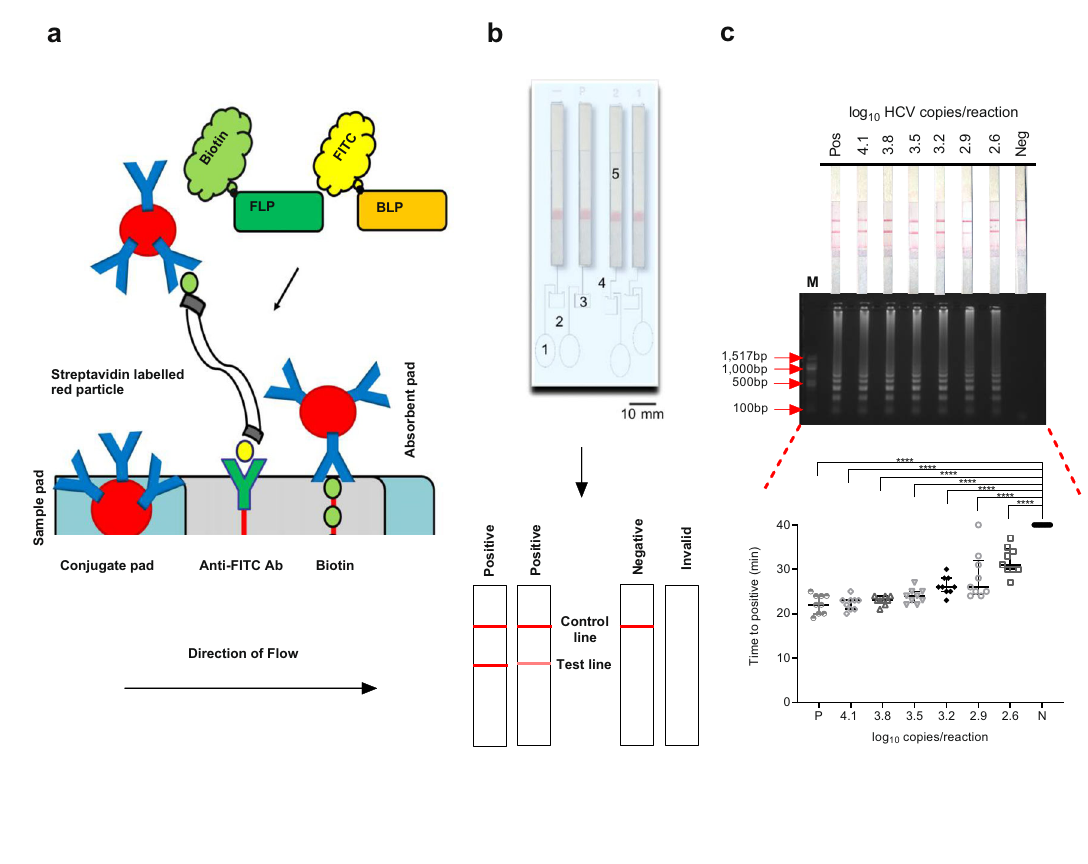
Fig. 3 Lateral fl ow detection of HCV LAMP assay. a The mechanism of the lateral fl ow strip 15 . Two primers, FLP and BLP, are pre-labelled with Biotin and FITC, respectively. The amplicon resulting from the LAMP reaction, contains both labelled primers as double-stranded DNA represented schematically by two gray lines. It is added onto the sample pad and moves towards the conjugate via capillary action. The streptavidin-labelled red particles bind with the Biotin (from the FLP primer) on the amplicon and together move towards the test line. The anti-FITC antibody (Ab) on the strip captures the amplicon via its FITC label (from the BLP primer) at the test line forming a band. Any unbound red particles move towards the control line where they are captured via the Biotin forming a second band. b The assembly and interpretation of the lateral fl ow devices. The device consists of the water chamber (1), connecting channels (2), four LAMP reaction chambers (3), channels (4) and lateral fl ow strips (5). Following the incubation period, two bands indicate a positive reaction, one band indicates a negative and no bands indicate invalid results. P — positive, N — negative, 1 and 2 — sample in duplicate. c Analytical sensitivity of the lateral fl ow method (top panel) compared to gel electrophoresis (middle panel) and fl uorescence over time (bottom panel). Serial dilutions of plasmid JFH1 replicon were made based on copy number per reaction (log 10 ). Black lines indicate median with interquartile range ( n = 3 biologically independent experiments, each with three technical replicates). The different symbols are for each dilution, to ease visualisation (grey and white disc — 4.1, white lozenges — 3.8, inverse triangles — 3.5, black diamond — 3.2, grey circles — 2.9 and white squares — 2.6 log 10 copies/reaction, black disc is negative control — DI water). Statistical analysis for the fl uorescence over time was performed using a parametric, one-way ANOVA. The F ratio = 55.56 and the degrees of freedom = 65. **** p ≤ 0.0001, Pos — positive HCV control, Neg — no template control, M — 100 bp NEB DNA ladder, C — control line, T — test line. Source data are provided as a Source data fi